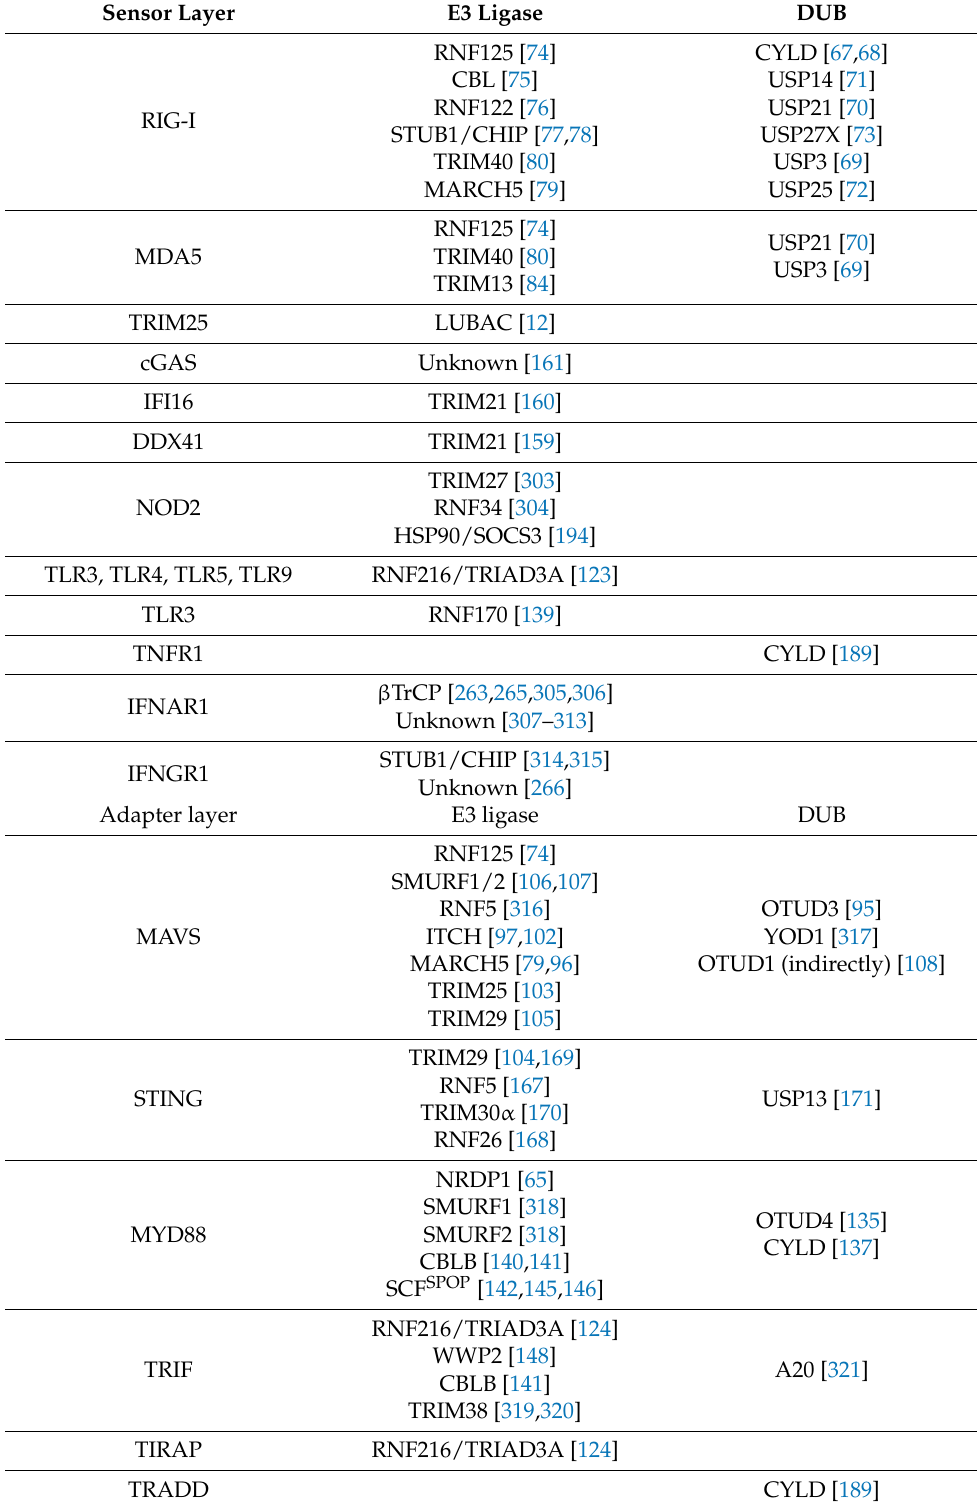
Table 1. Negative regulators of innate immune signaling